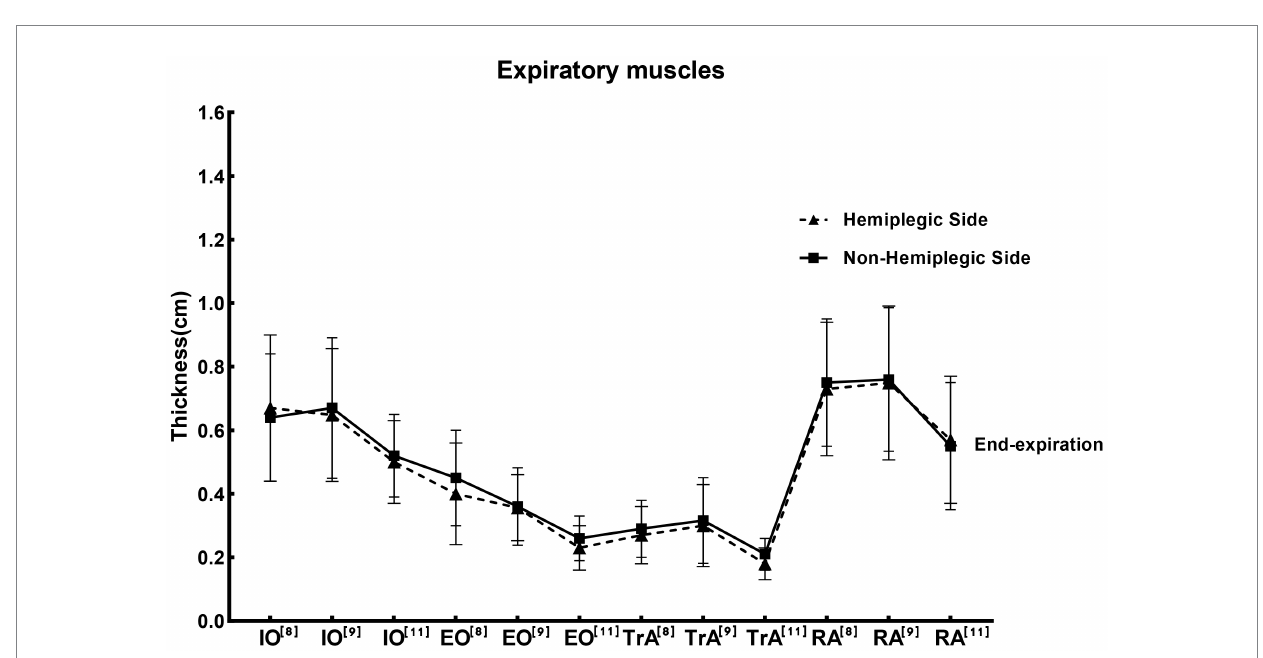
FIGURE 3 Studies for the thickness of the expiratory muscle ultrasound in stroke patients. The reference values of the thickness of expiratory muscle at end- expiration measured by ultrasound in different studies in Supplementary material 2, presented by the mean ± standard deviation. Where the solid line was the thickness of the expiratory muscles on non-hemiplegic side, while the dotted line was the hemiplegic side. Labels at the top-right of the abbreviations on the abscissa axis, such as [8],[9],[11], are shown in Supplementary material 2. The abbreviations on the abscissa represented different studies. IO, Internal oblique muscle; EO, External oblique muscle; RA, Rectus abdominis muscle; TrA, Transversus abdominis